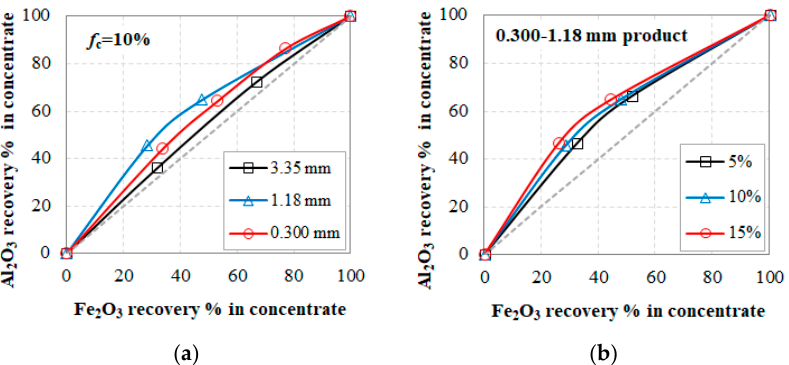
Figure 14. The Fuerstenau-II upgrading curves for different ( a ) feed fractions when f c was 10% and ( b ) material filling volumes f c when the 0.300 – 1.18 mm feed fraction was used.